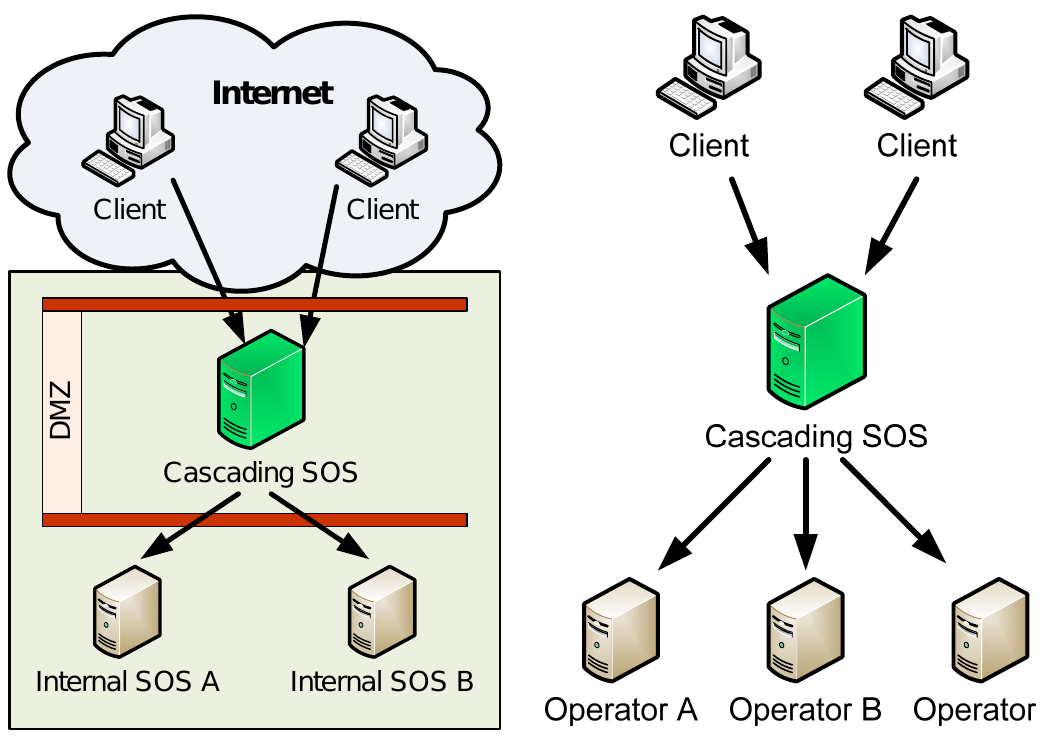
Figure 2. From left to right: (a) UC1 “data publishing”; (b) UC2 “custom view to